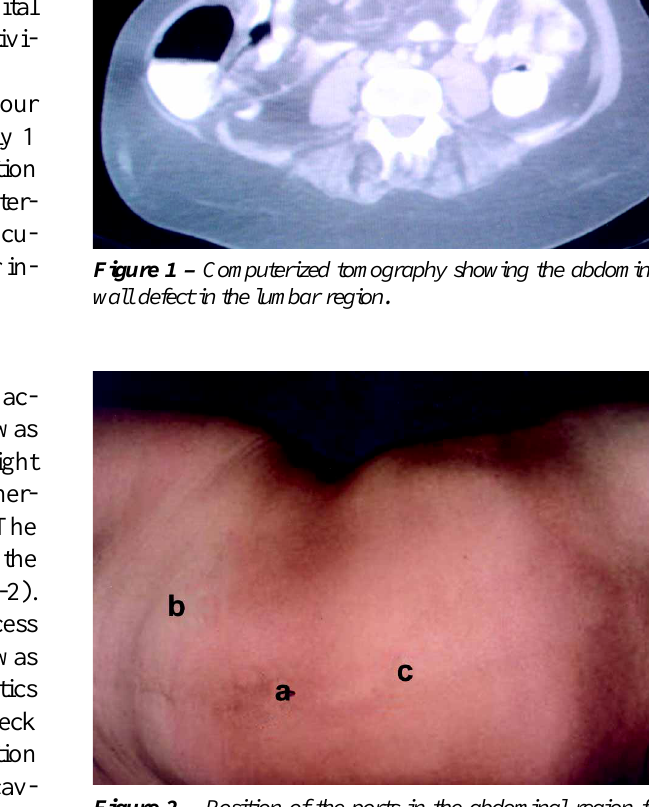
Figure 2 – Position of the ports in the abdominal region for repair of incisional lumbar hernia: a = 10-mm trocar at the umbilicus; b = 5-mm trocar at mid-clavicular line, 2 cm below the umbilicus; c= 12-mm trocar at midline between umbilicus and xiphoid process.